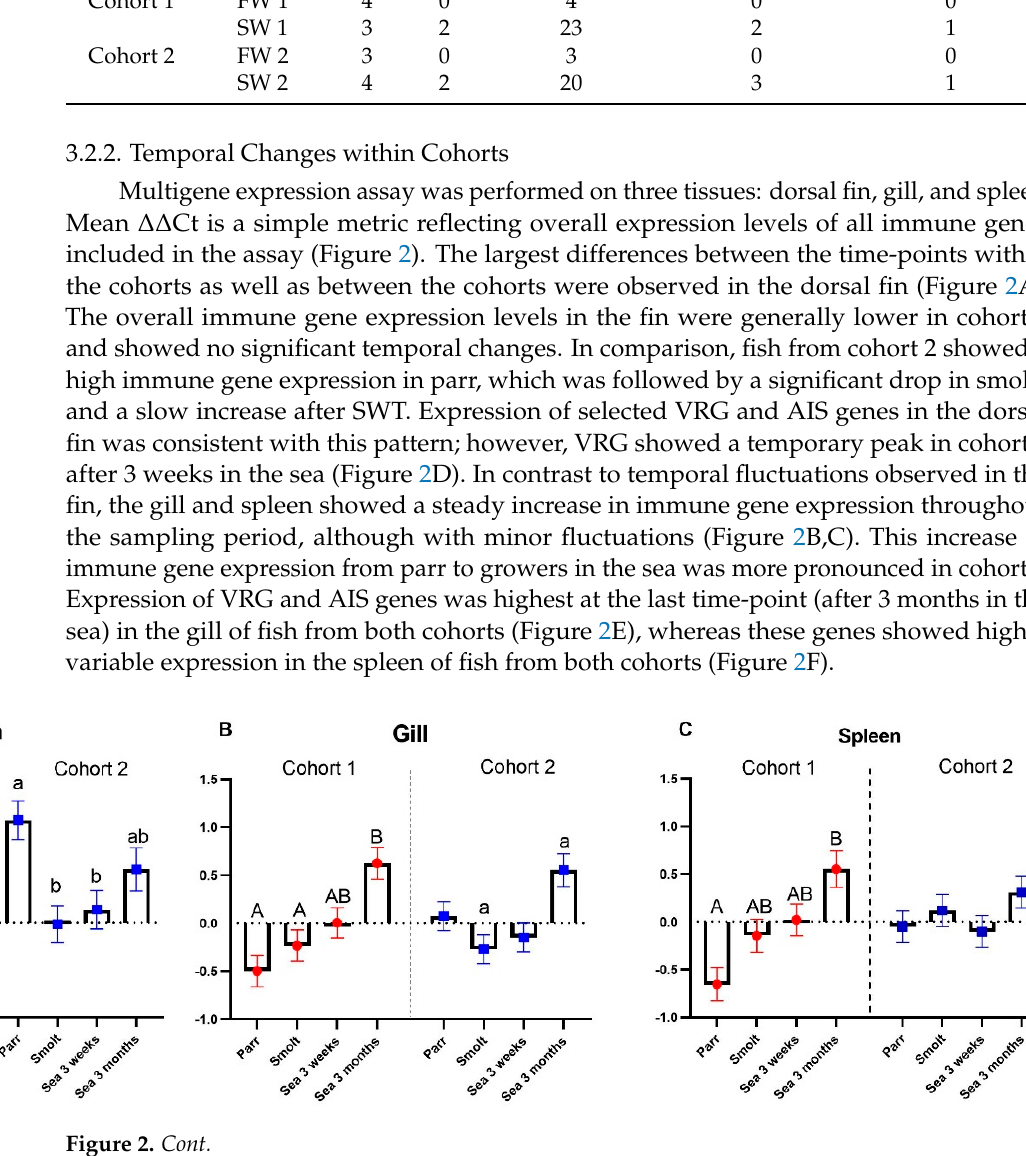
Table 2. Numbers of fish with PCR detected pathogens in the multigene expression assays. Cohort, site, and sampling time-point are indicated.